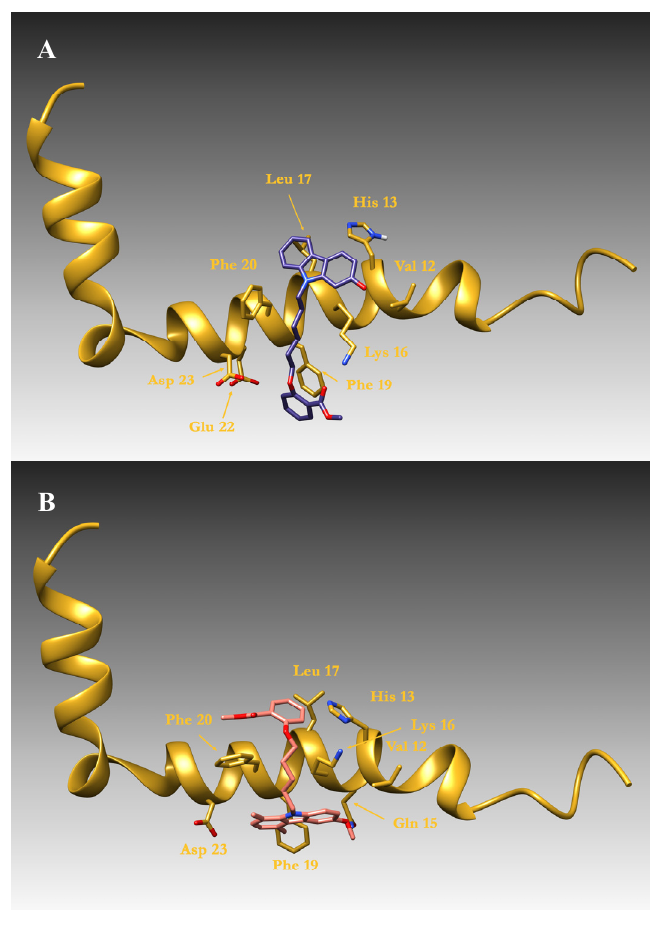
ribbon cartoon. Residues involved in ligand binding are drawn as sticks. Panels ( A ) and ( B ) report, respectively, the binding mode of the compound 2-OH CARB 6B ( 4 ), drawn